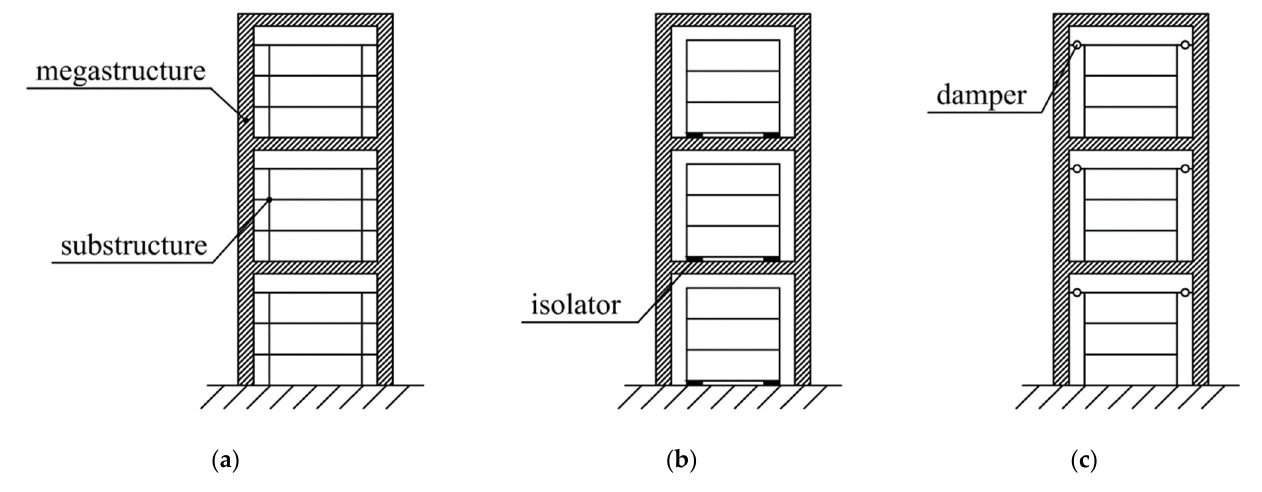
Figure 1. Configurations of MFVCS. ( a ) MFS. ( b ) MFVCS with isolators. ( c ) MFVCS with dampers.